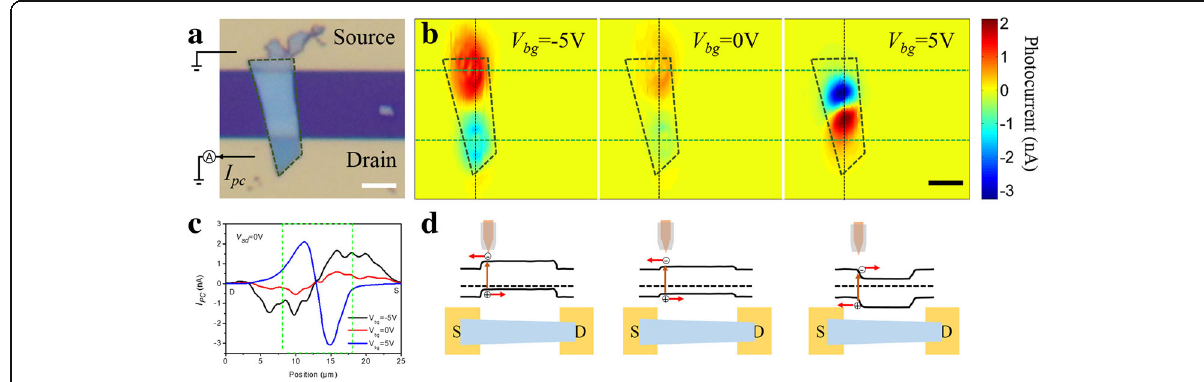
Fig. 3 Spatial-resolved photocurrent images of D1 as a function of gate voltage. a The optical image together with the electrical setup. b Spatial- resolved photocurrent images at V bg = − 5, 0, and 5 V, respectively. c I PC profile collected from the black dashed line in Fig. 3b. d Corresponding potential profiles at V bg = − 5, 0, and 5 V, respectively. The scale bars are 5 μ m in all